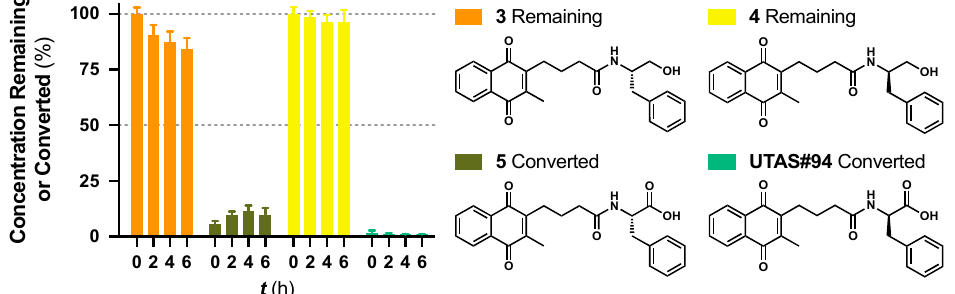
Figure 3. Metabolic stability of enantiomers 3 and 4 and their metabolic conversion to their oxidized forms 5 . and UTAS#94 , respectively. The concentration of 5 and UTAS#94 were calculated according to their analytical figures of merit, followed by normalization over the initial recovered concentrations of 3 and 4 , respectively. Data was expressed as mean ± SEM from three independent experiments, with at least 3 data points